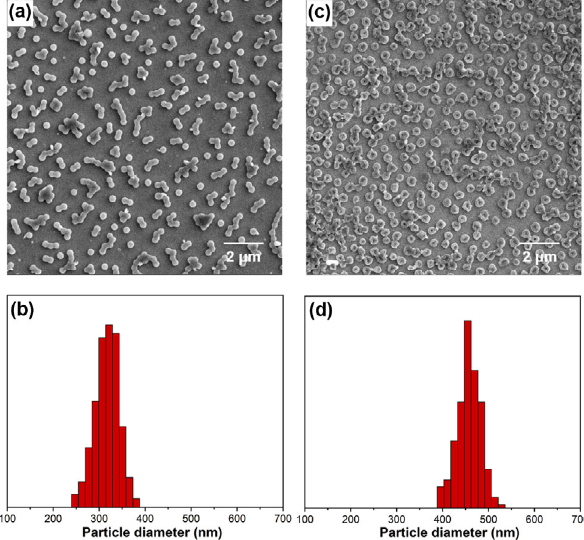
Fig. 4 SEM images and corresponding size distribution histograms of (a, b) MGs-Br and (c, d)